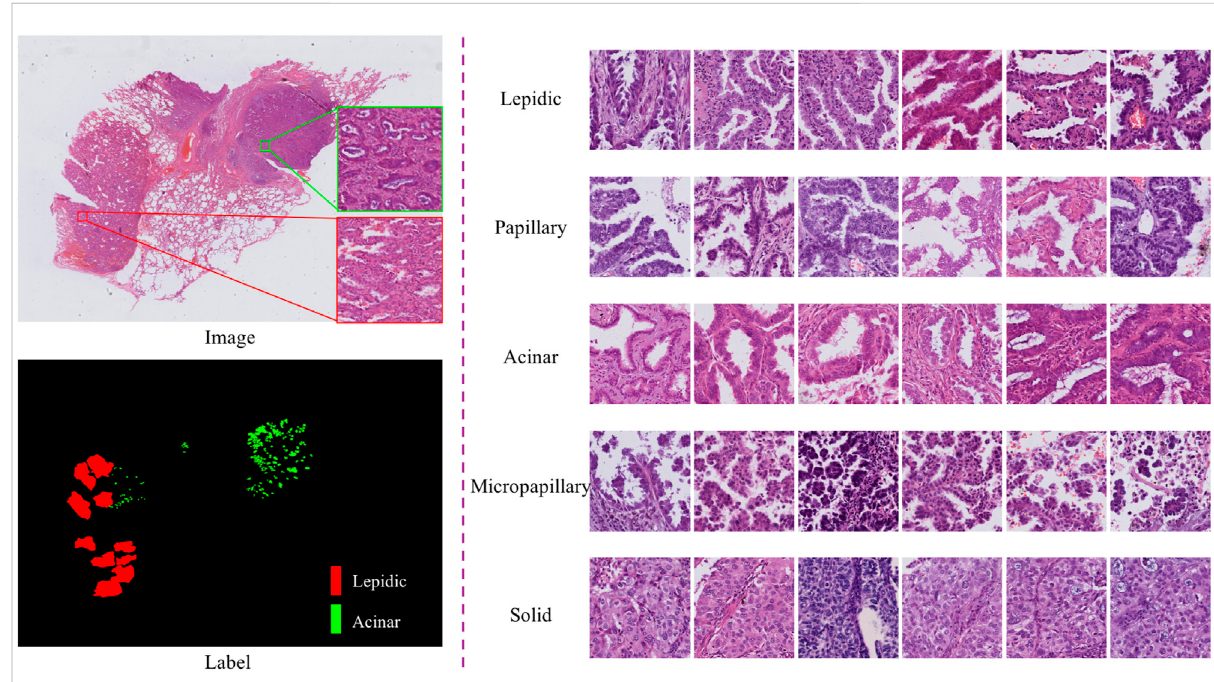
FIGURE 1 Pictures of typical growth patterns. Left: An example of an HandE-stained digital pathology image with manual segmentation of growth patterns, where red is the lepidic growth pattern and green is the acinar growth pattern. Right: Five common growth patterns (lepidic, papillary, acinar, micropapillary, and